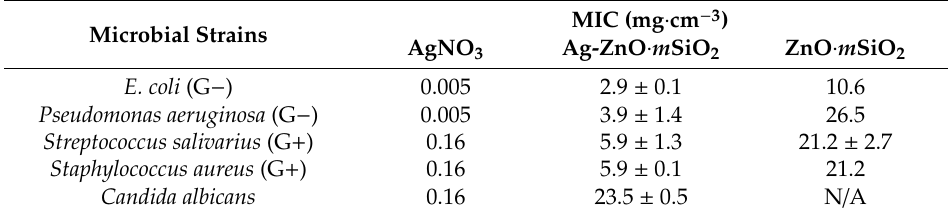
Table 2. MIC (mg · cm − 3 ) for materials tested on various microbial strains of gram-positive (G + ) and gram-negative (G − ) bacteria. Values without deviation had the same MIC in all three tests. N / A means that MIC was not found in the measured range.